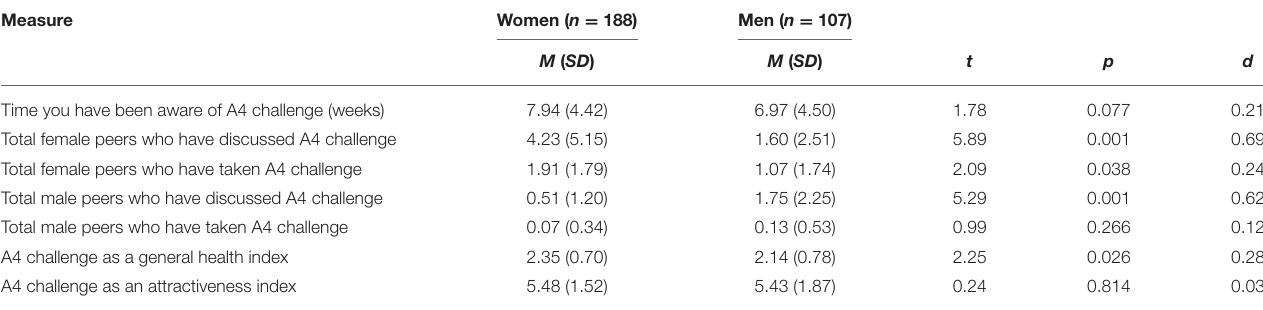
TABLE 2 | Gender differences in personal awareness of A4 challenge, peer group experiences of A4 challenge, and perceptions of A4 challenge as an index of health and attractiveness ( N = 295). Measure Women ( n = 188) Men ( n = 107) M ( SD ) M ( SD ) t p